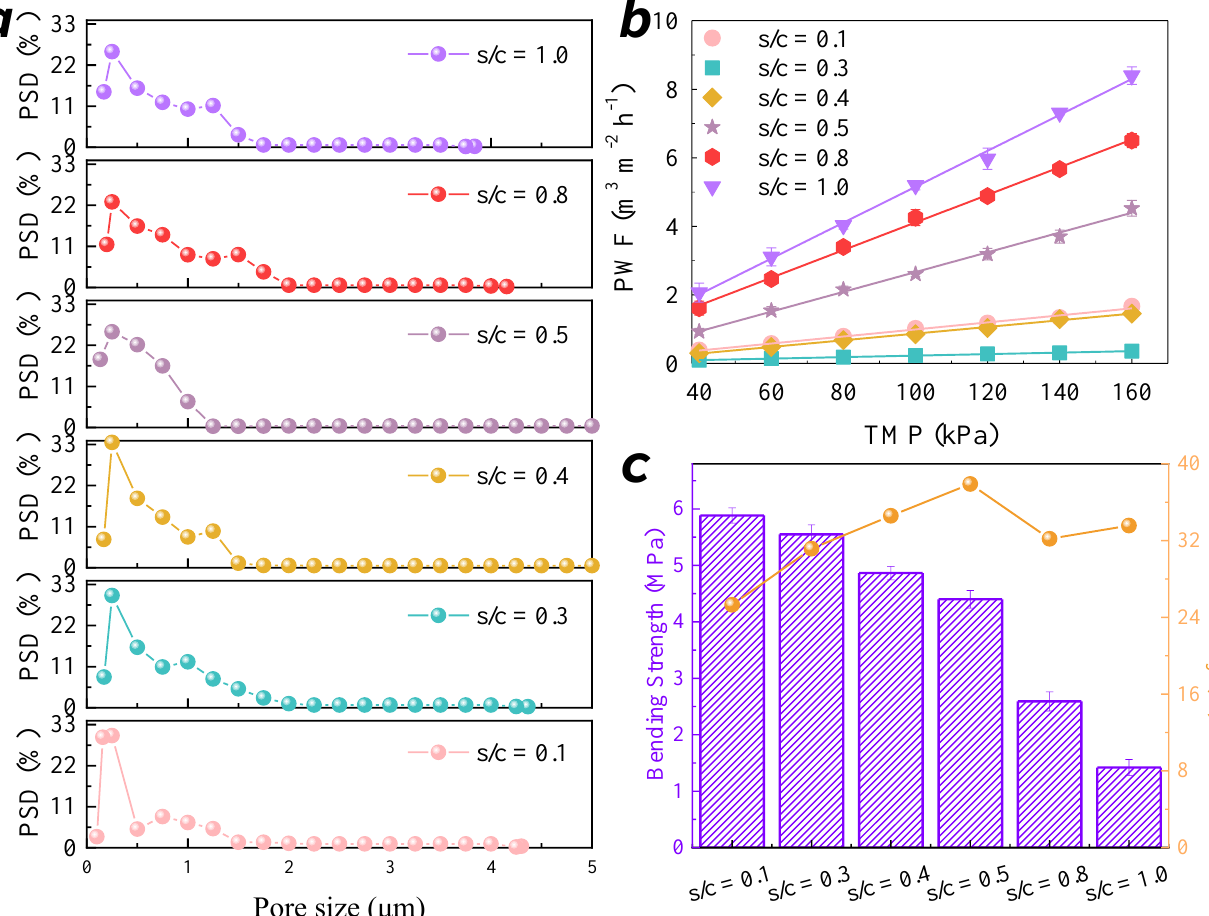
Figure 1. Characterization of CMs fabricated by a series of s/c ratios. ( a ) Pore size distribution of CMs; ( b ) PWF of CMs; ( c ) bending strength and porosity of CMs.